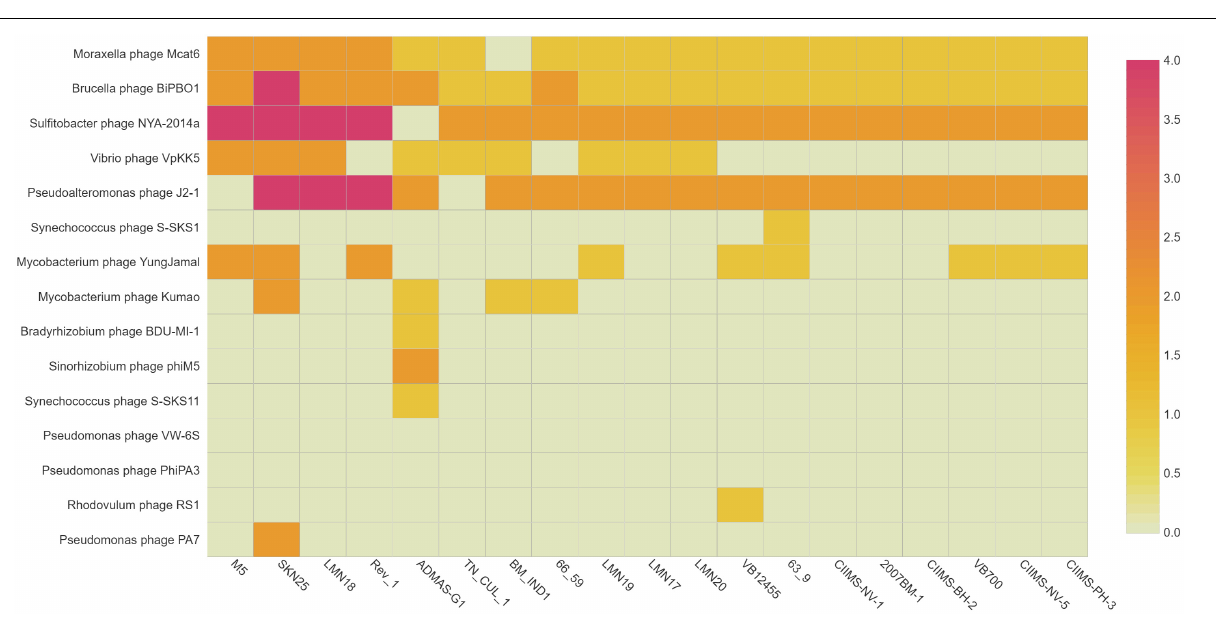
FIGURE 3 | Prophages identified among the 19-genome